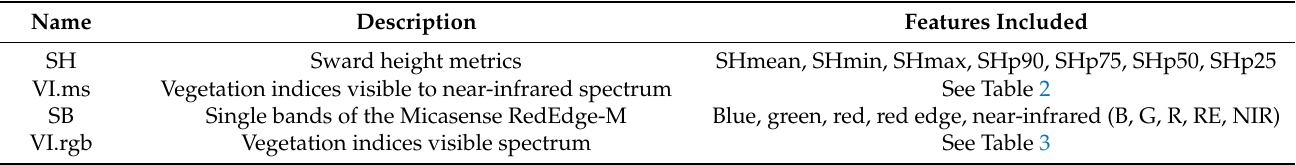
Table 4. Feature